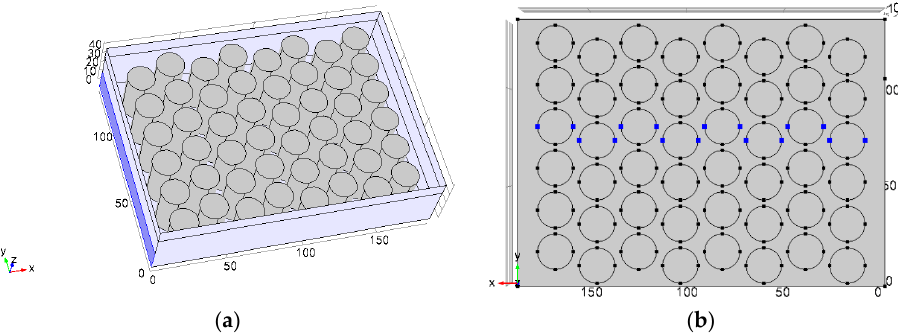
Figure 4. ( a ) A quarter of the schematic view for a cross arrangement; and ( b ) distribution of the monitoring points.